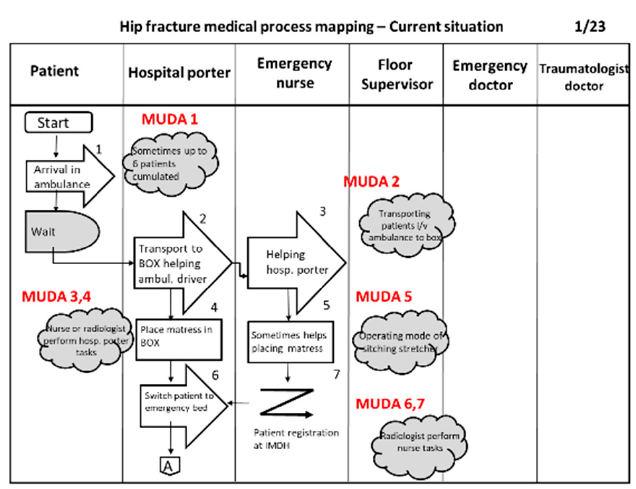
Figure 3. Flow diagram (partial) showing the existing process.